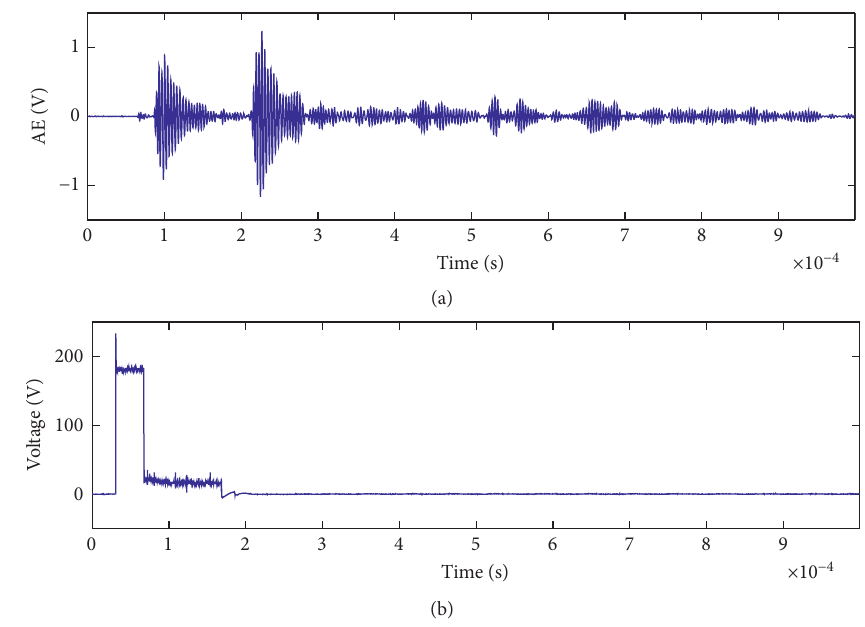
Figure 7: AE wave generated by discharge in a water-based